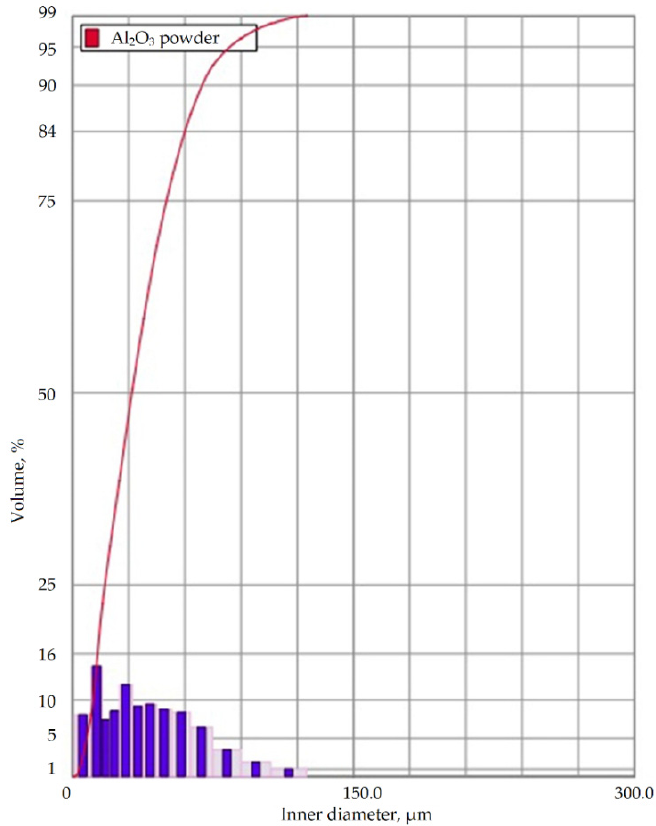
Figure 3. Granulometric analysis of the composition of aluminum oxide powder. Granulometric analysis (Figure 4, Table 7) of SnO powder showed that the powder sample had an average inner diameter of 63.79 µm and 33.46 µm for 50% of the particles. The average circularity of the tin oxide powder is about 0.597 µm and about 0.625 µm for 50% of the particles. Table 7. Granulometry of tin oxide powder. Inner Diameter Range, µm